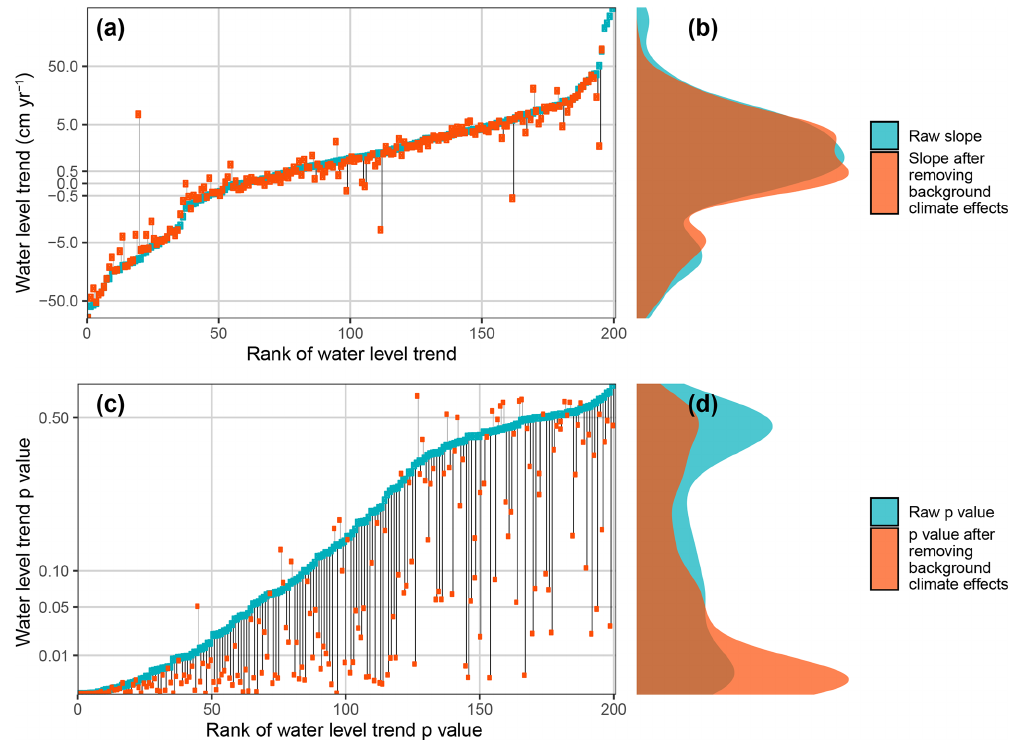
Figure 1. The change in each lake’s water level trend (a, b) and their trend p value (c, d) which resulted from removing the effects of background climate variation on water level variation in 200 globally distributed large lakes. After removing the effects of background climate variation on water levels, long-term water level trend estimates (orange) were slightly more conservative overall compared to rates calculated from the raw water level data (turquoise). The median value of water level trends across lakes changed from + 1 . 2 to + 0 . 8cmyr − 1 after removing the effects of background climate variation. The trends became more statistically significant in most (86%, black lines below the curve) but not all lakes (14%, gray lines above the curve) after accounting for the effects of background climate variation. The median p value of water level trends across lakes changed from 0.16 to 0.02 after removing the effects of background climate variation. Lakes are ranked independently in panels (a) and (c)